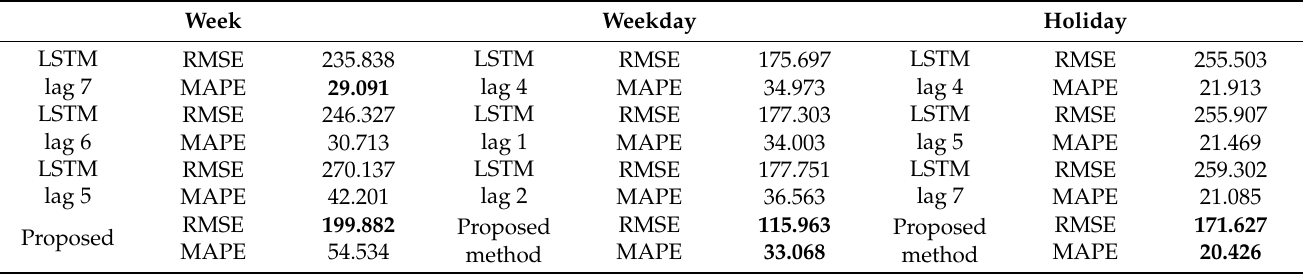
Table 6. Results of proposed model for Route 1 based on minimal RMSE.